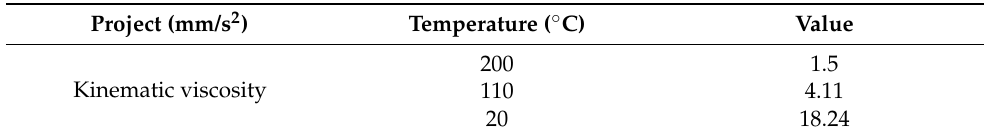
Table 2. Kinematic viscosity of the lubricating oil.